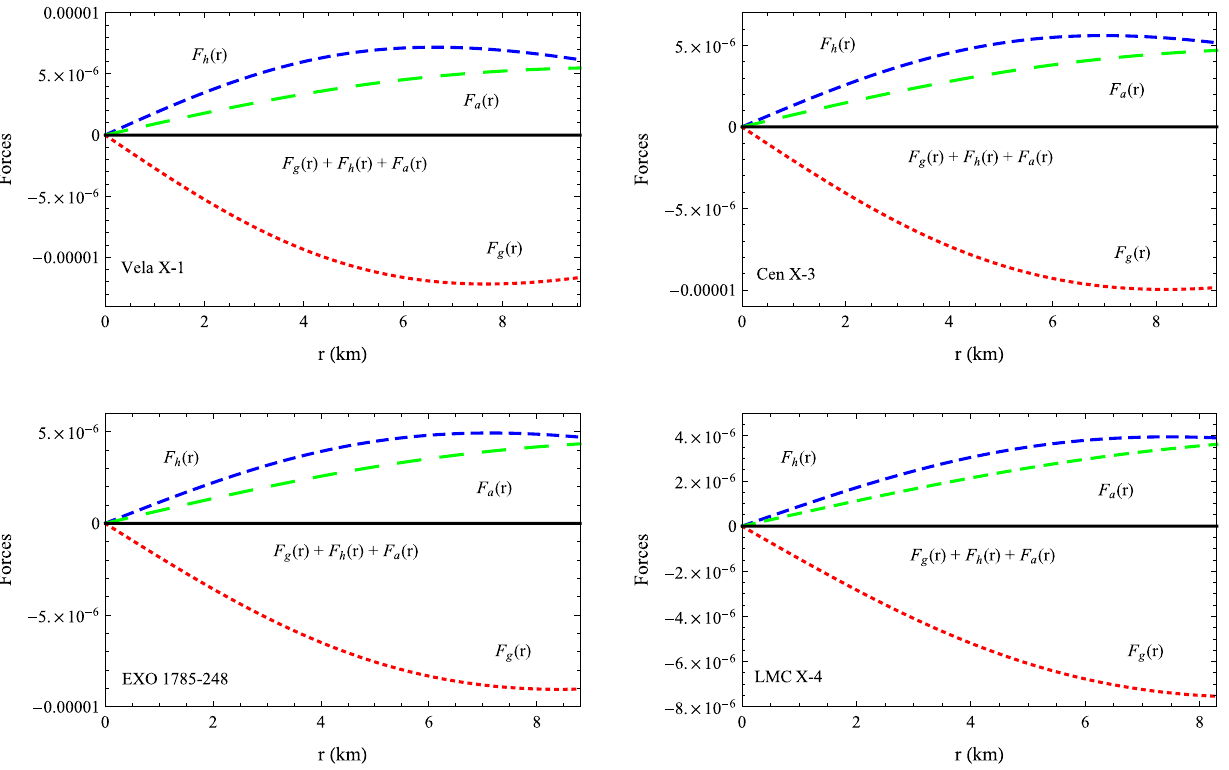
Fig. 8 Forces for the compact stars Vela X-1 (above left), Cen X-3 (above right), EXO 1785-248 (below left), LMC X-4 (below right) vs the radial coordinate r corresponding to numerical values of constants given in Table